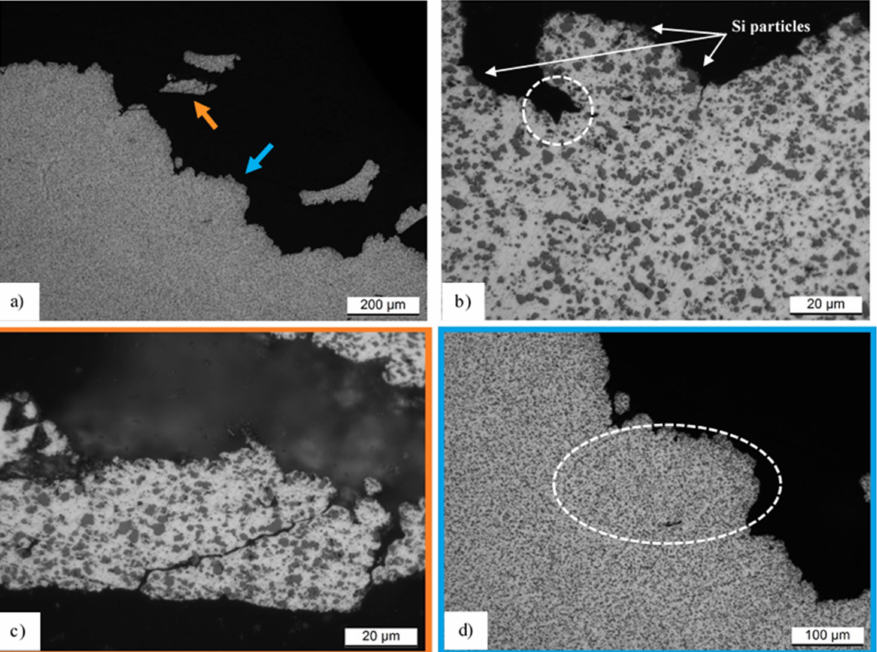
Figure 10. Fracture profile ( a ) of the T6 heat-treated sample (2) where the orange and light-blue arrows indicate two different zones shown in ( c , d ). The micrograph ( b ) shows another area of the same